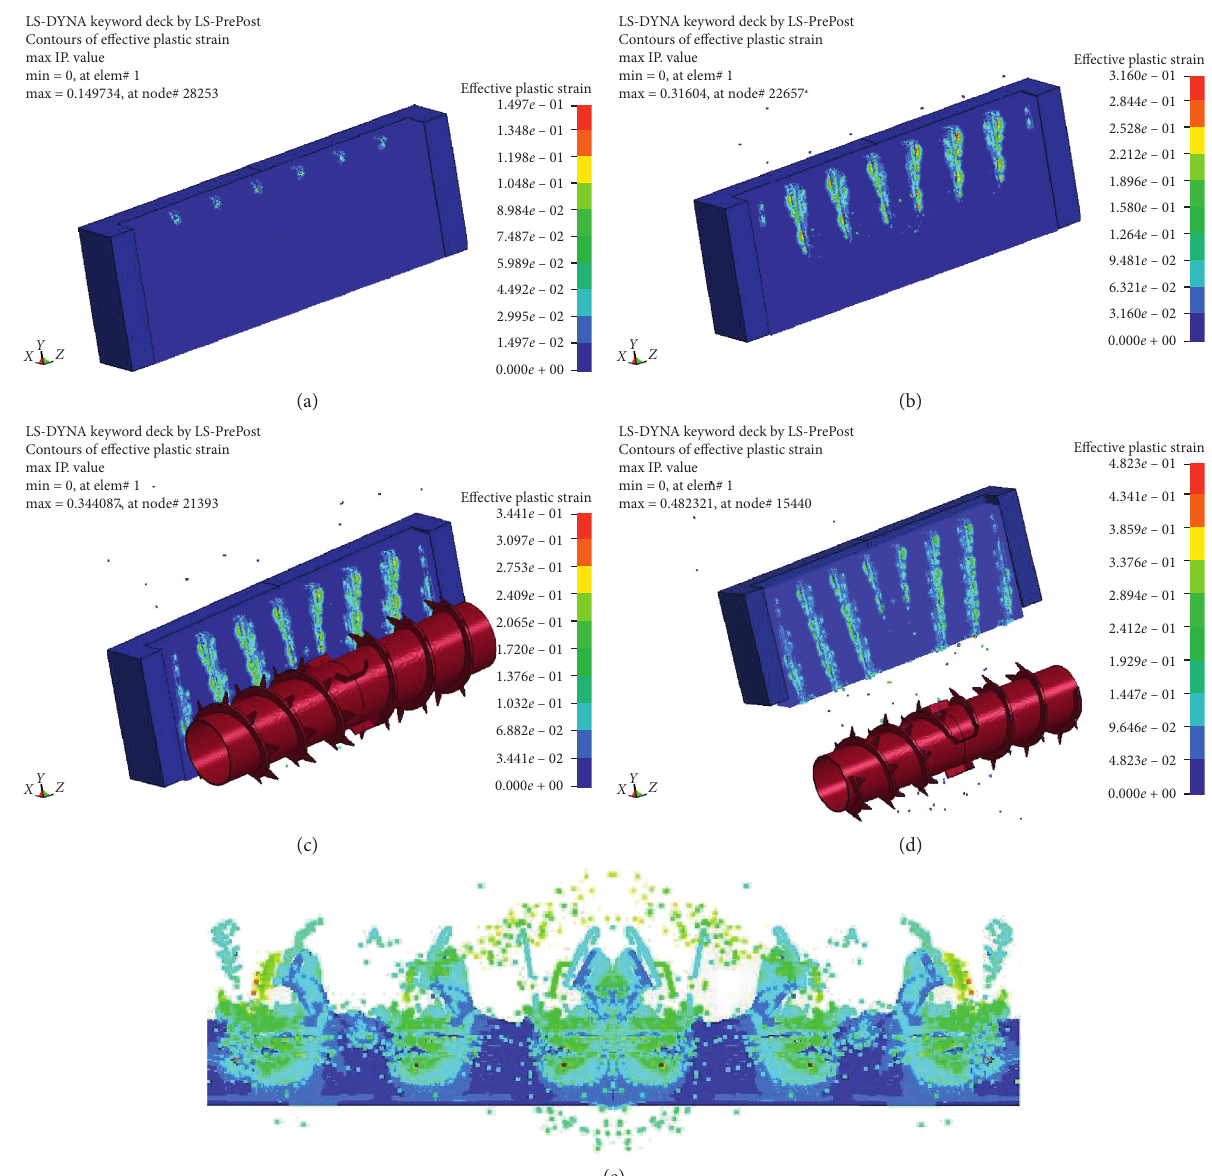
Figure 11: Equivalent plastic strain nephograms of silage at different times: (a) 20ms; (b) 60ms; (c) 100ms; (d) 200ms. (e) Enlarged partial top view of silage cutting at